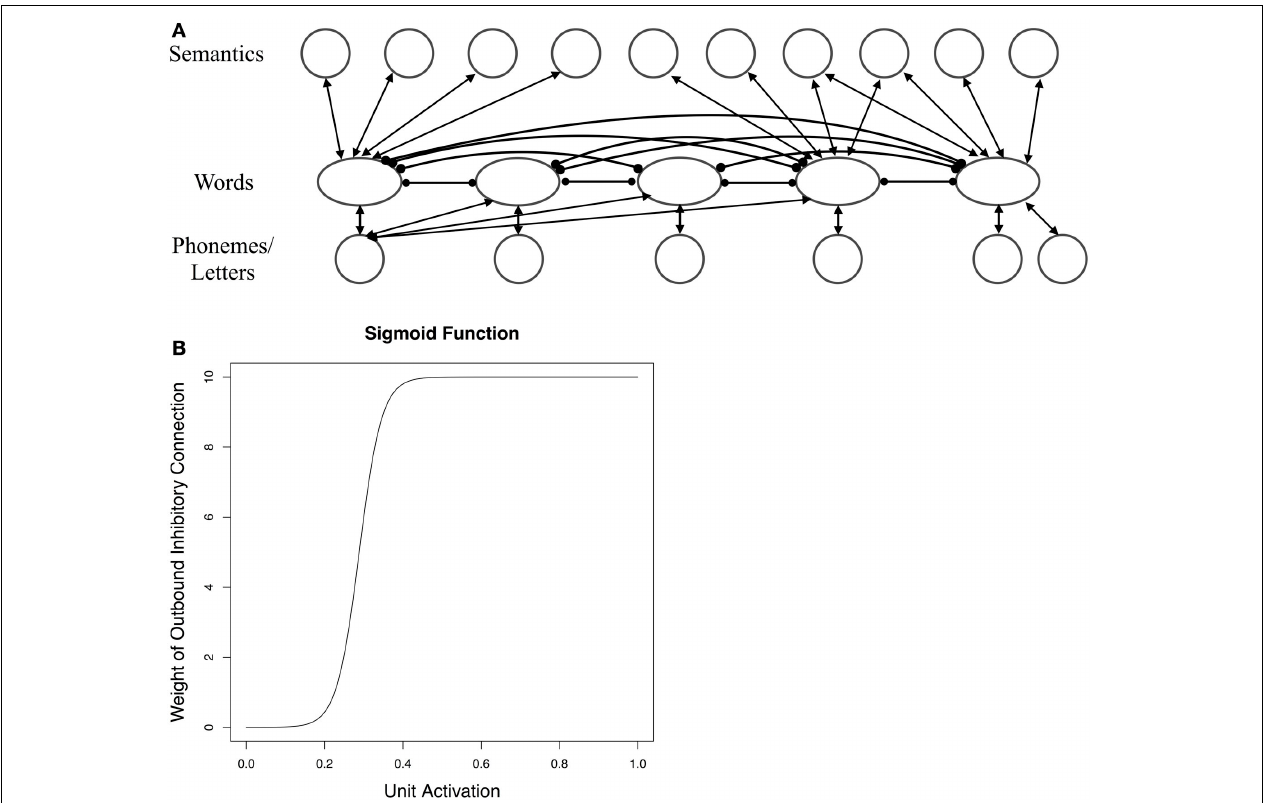
FIGURE 1 | Chen and Mirman (2012) Architecture. Panel (A) illustrates the spreading activation architecture used by Chen and Mirman (2012) to account for the pattern of reversals of neighborhood density effects in spoken and written language. Facilitatory connections are drawn with